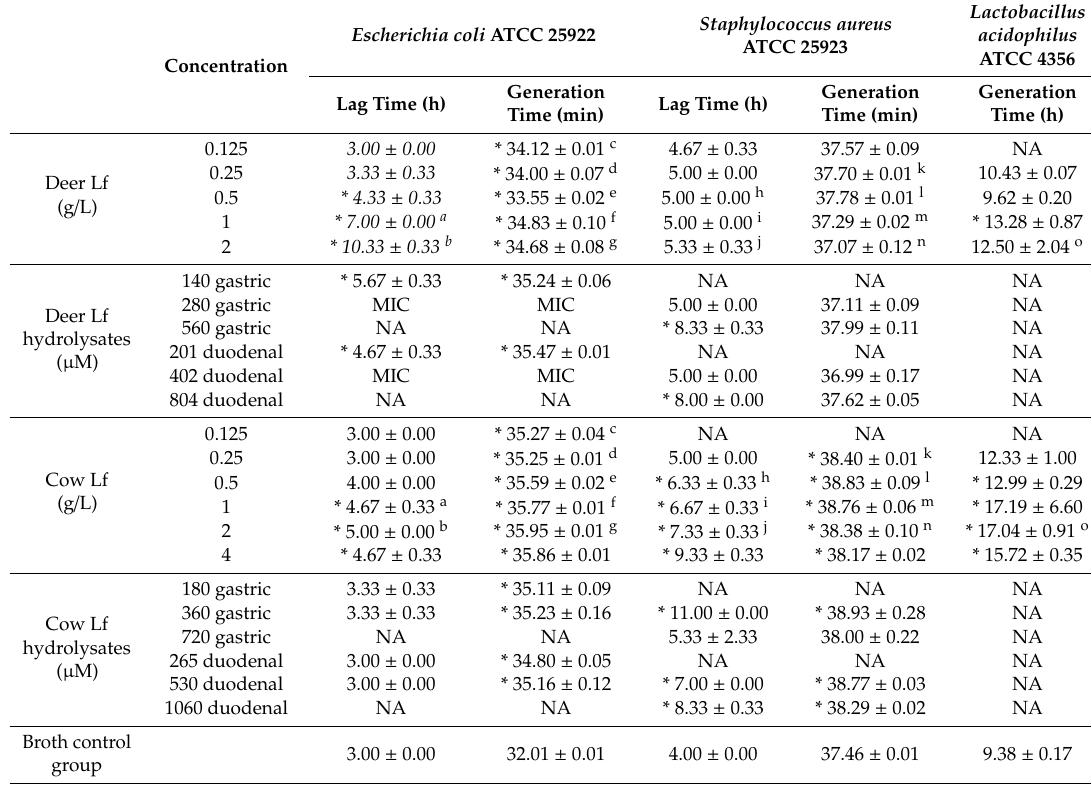
Table 1. Growth curve parameters of bacteria treated with deer and cow Lf and their hydrolysates.